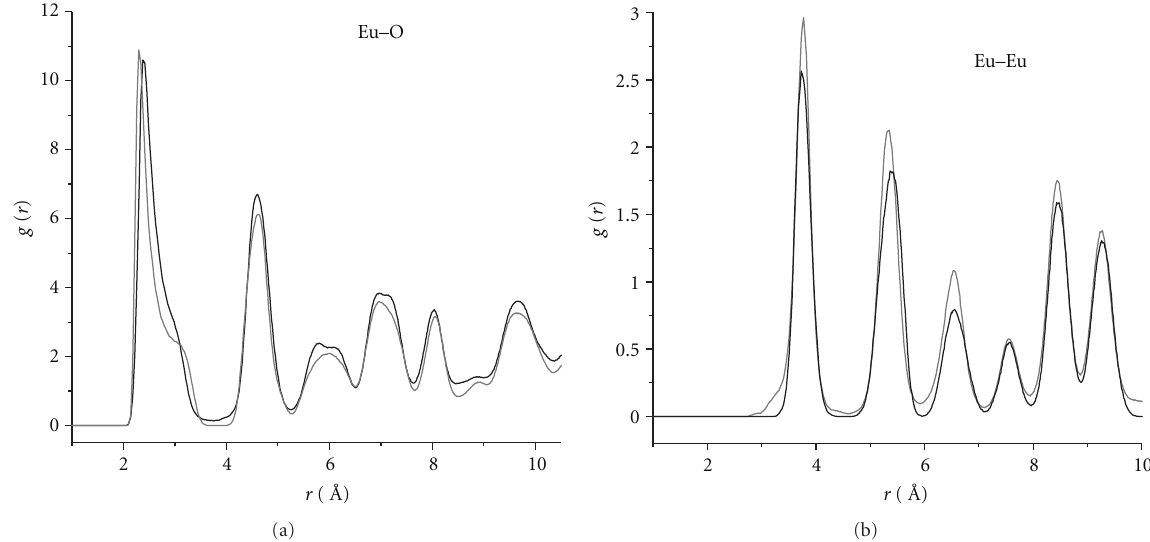
Figure 7: Radial distribution functions from molecular dynamics simulations for the pairs shown for samples La 0 . 3 Eu 0 . 7 AlO 3 (black line) and EuAlO 3 (gray